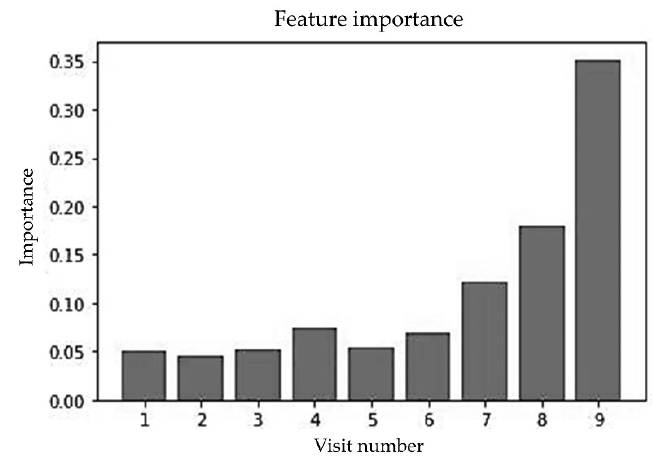
Figure 15. Feature importance of random forest for multiple random visits (unbalanced data).